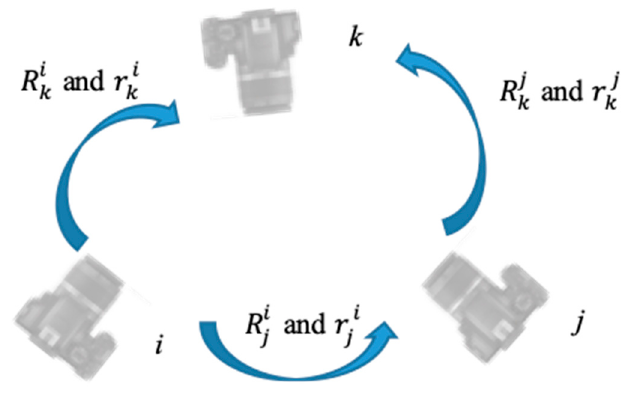
Figure 4. Image triplet for establishing the local coordinate system.